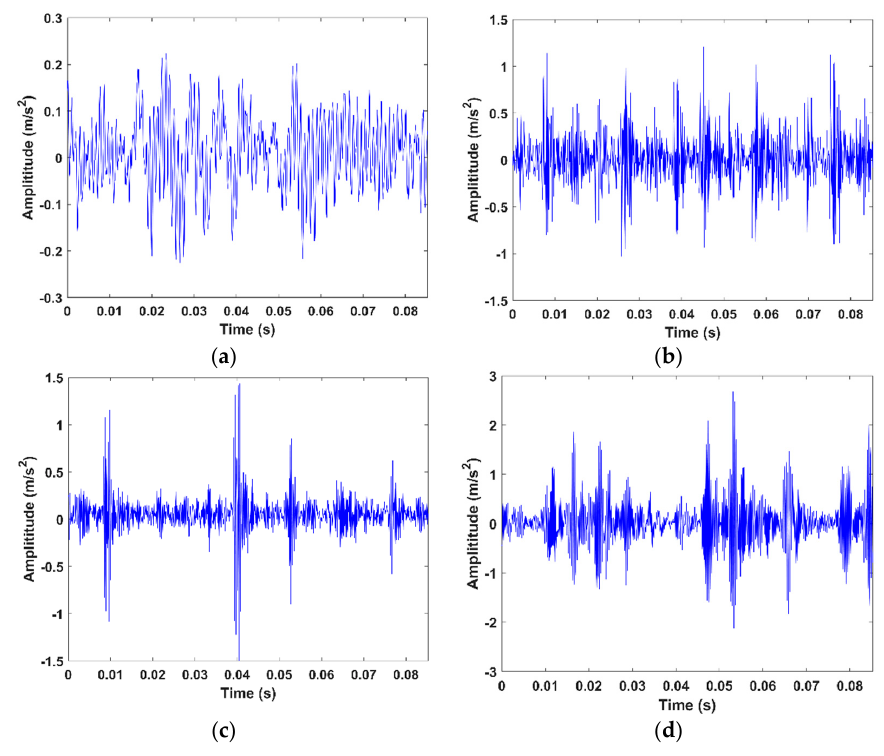
Figure 7. Time-domain waveforms of the vibration signals of bearings with four different faults severity degrees at the inner race: ( a ) 0.000 in, ( b ) 0.007 in, ( c ) 0.014 in, and ( d ) 0.021 in.